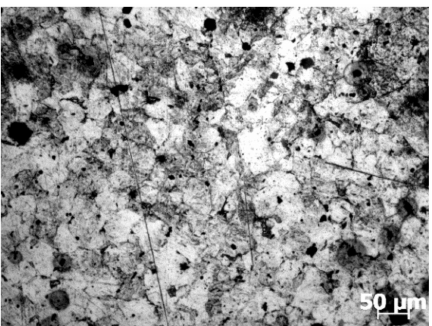
Figure 3. Initial optical micrograph of the rolled SAE 5137H steel